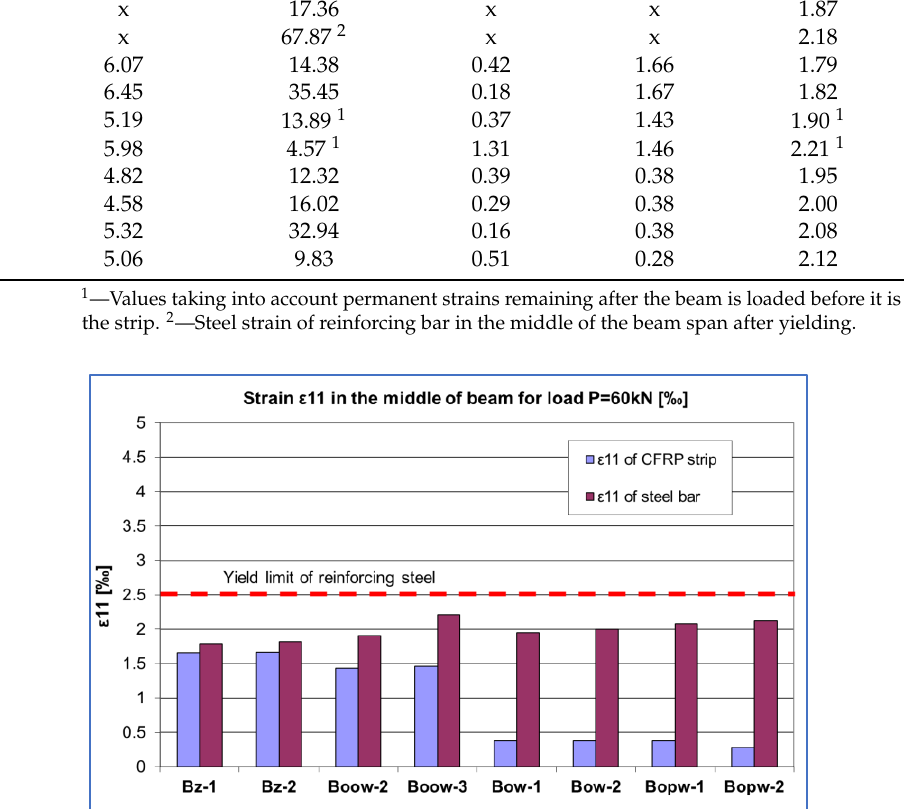
Table 4. Values of strains of CFRP strip and the bar in the middle of beam span.